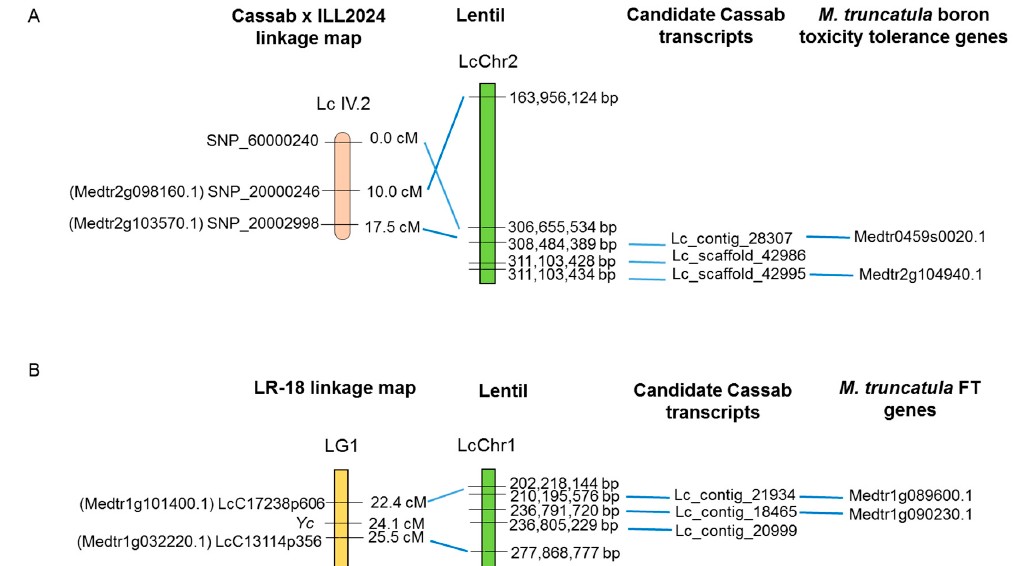
Figure 5. Schematic depictions of comparisons between ( A ) the boron tolerance quantitative trait loci (QTL)-containing-interval on linkage group (LG) Lc IV.2 of the Cassab × ILL2024 linkage map and both lentil genome assembly v1.2 and candidate Cassab transcripts with corresponding M. truncatula boron tolerance candidate gene sequences; ( B ) The flowering time QTL-containing interval on LG1 of the LR-18 linkage map and both lentil genome assembly v1.2 and candidate Cassab-derived transcripts with corresponding flowering time genes from M. truncatula . LGs or pseudomolecules are labelled accordingly. The names of genetic markers are shown to the left of each LG.